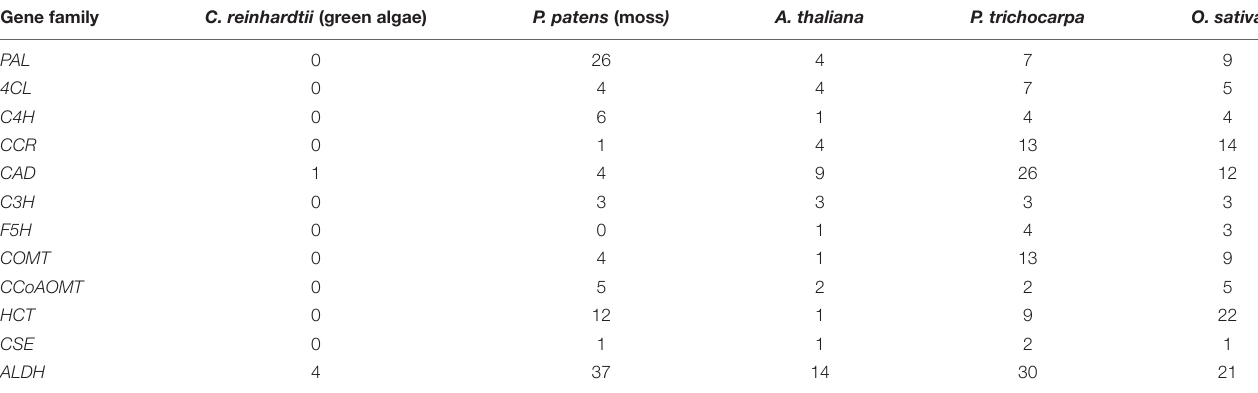
TABLE 1 | Copy number variation of lignin biosynthetic genes in selected model species. Gene